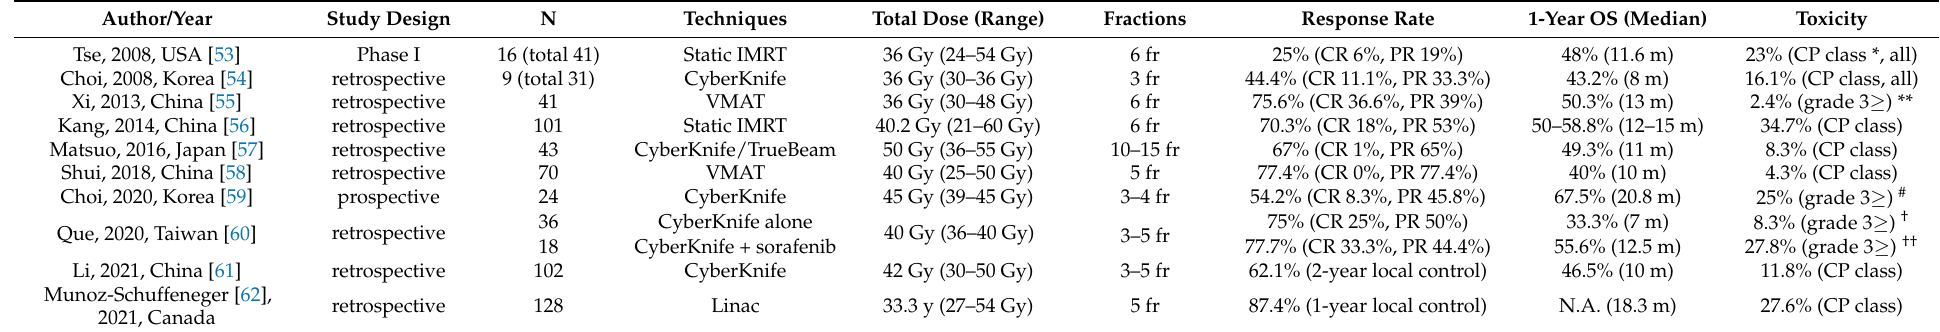
Table 3. SBRT for portal vein/inferior vena cava tumor